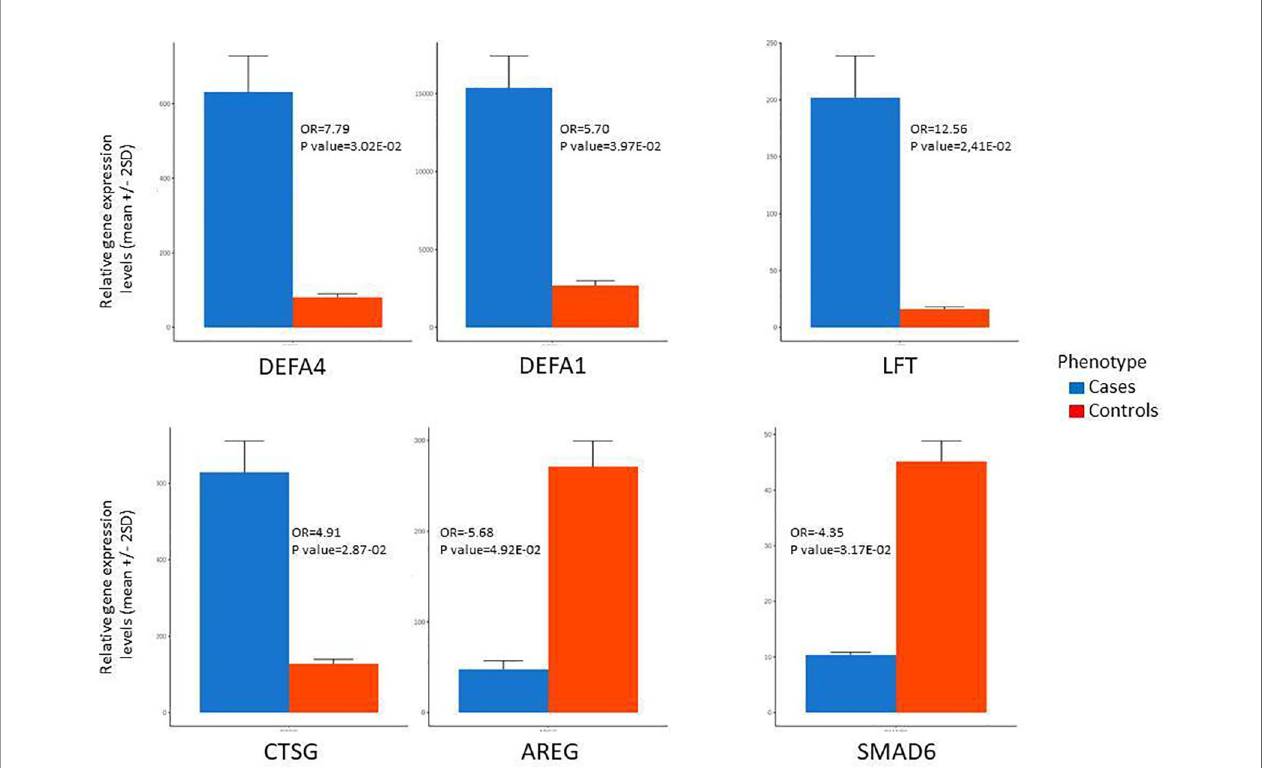
FIGURE 3 | Most differentially expressed genes between patients with type 1 diabetes (cases) and health controls based on microarrays data. AREG, Amphiregulin; CTSG, Cathepsin G; DEFA1, Defensin alpha 1; DEFA4, Defensin alpha 4; KCNMA1, Potassium Large Conductance Calcium-Activated Channel; LTF, Lactoferrin; SMAD6, Mothers Against Decapentaplegic Homolog